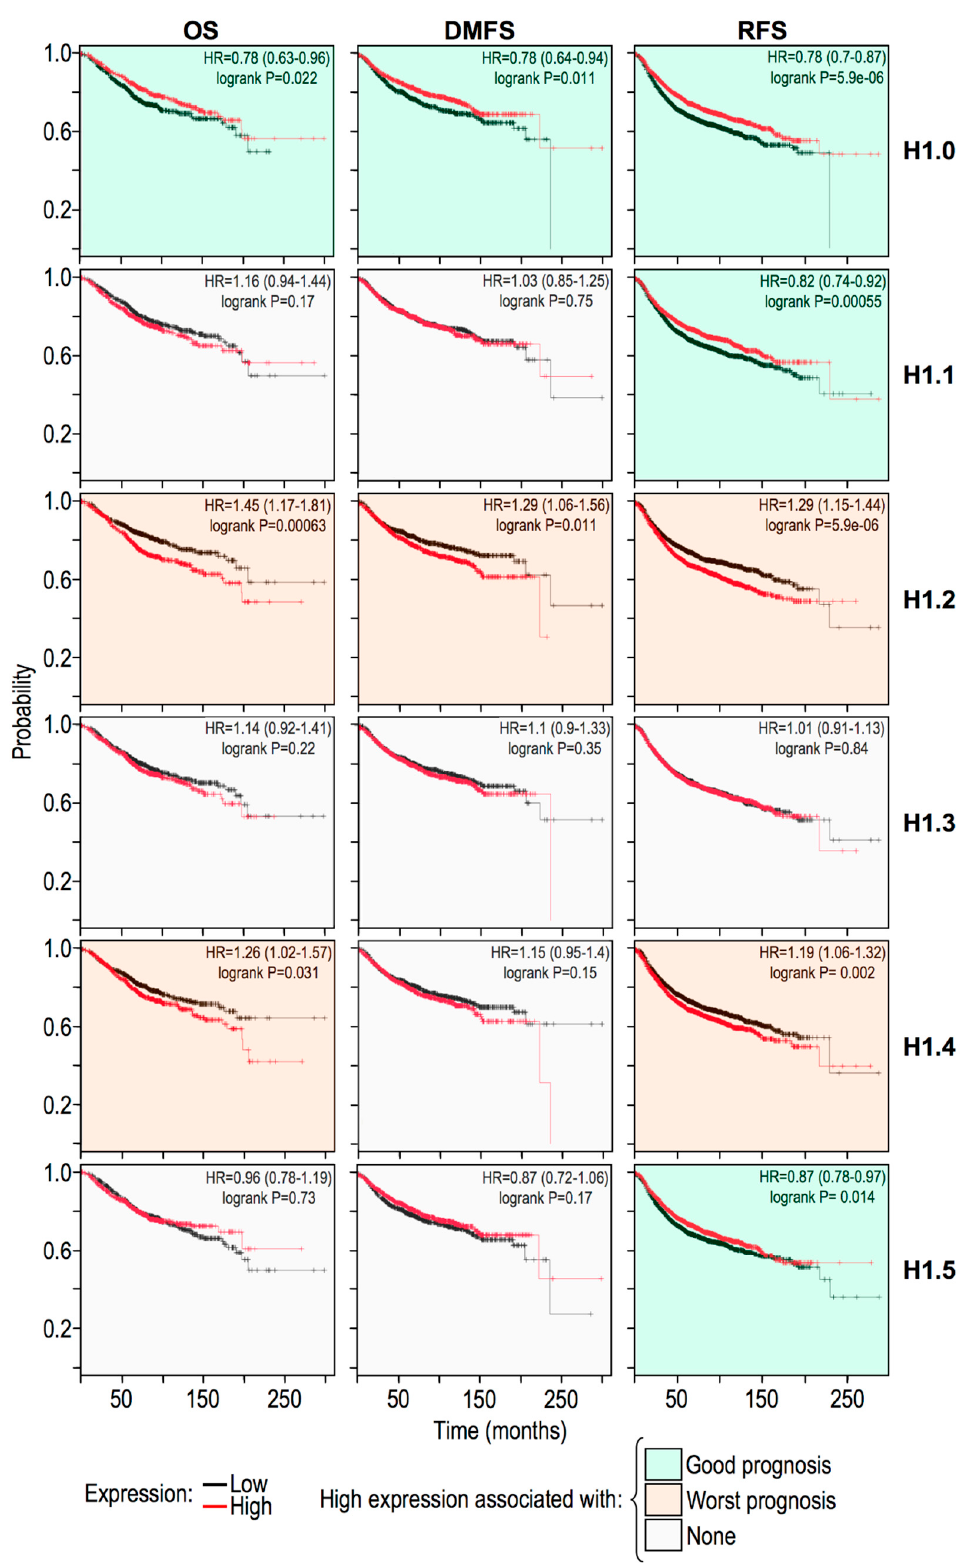
Figure 6. The prognostic value of histone H1 variants gene expression levels in breast cancer specimens. Kaplan–Meier plots for overall (OS), relapse-free (RFS), and distant-metastasis-free (DMFS) survival with regards to histone H1.0, H1.1, H1.2, H1.3, H1.4, and H1.5 gene expression level (low or high) in a collection of breast cancer gene expression data sets using KM plotter (kmplot.com).